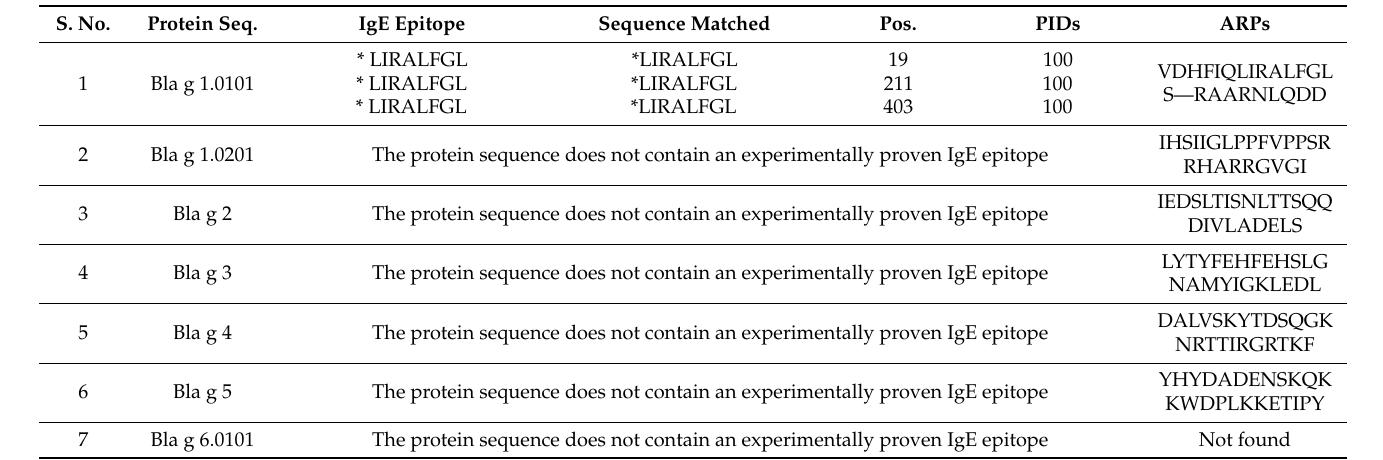
Table 3. AlgPred: Prediction of allergenic proteins and mapping of IgE